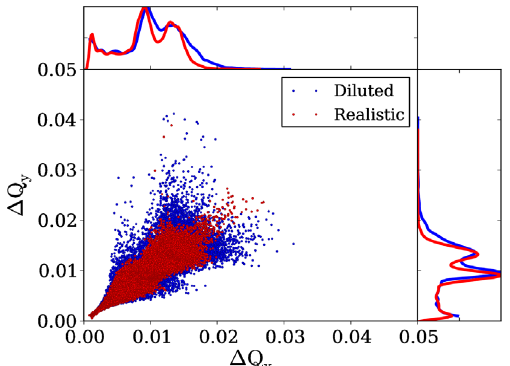
FIG. 10. Tune spreads for LHC-type bunch in a round pipe geometry without magnetic field. The blue dots represent the tune distribution induced by the diluted cloud. The red dots corre- spond to the tune distribution induced by the nonuniform cloud. ¼ 10 11 and the SEY δ ¼ 2 . 1 The bunch population is N i max